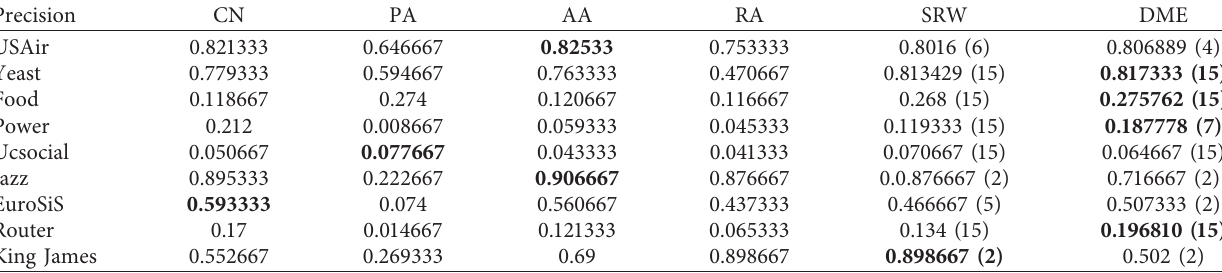
Table 3: Precision on the nine benchmark networks with L �